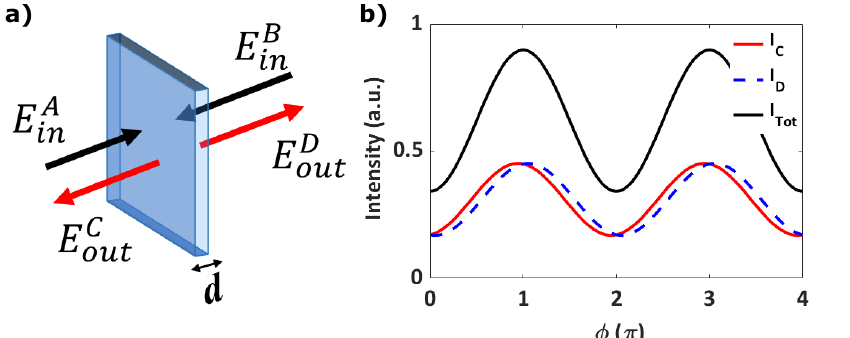
Figure 1. ( a ) Bi-directional coherent perfect absorption (CPA) scheme. ( b ) Intensity of the two output beams, C and D, and its sum as we scan the sample position in the propagation direction. This is equivalent to changing the relative phase between the two input fields φ